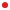
Principal component analysis of miRNA expression levels in PBL can classify patients with NCWS and controls.(A) A principal component analysis was performed on the ΔCt values for each gene. First component (PC1) was plotted against second component (PC2) to identify genes driving the two components and to explain the percentage variation. • Control group; + NCWS group. (B) Fitted ROC curve (blue line) of the first principal component data (red dots). Plotting of the true positive rate versus false positive rate as defined by the PC1 values. AUC = 0.84 ± 0.0624 (p<0.001, Wilcoxon U test). Grey lines: 95% confidence interval of the fitted ROC curve.